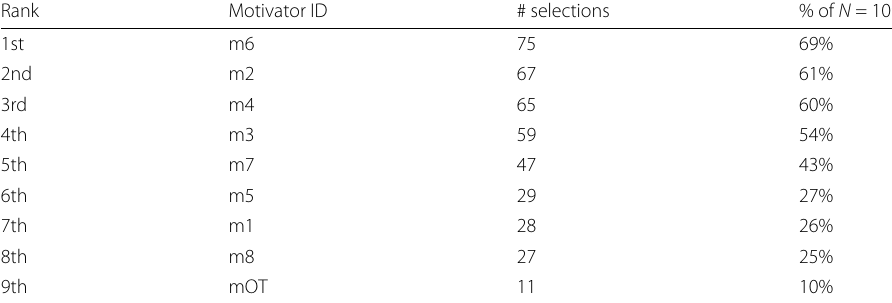
Table 10 Ranking of motivators for IoT application development and deployment based on selection